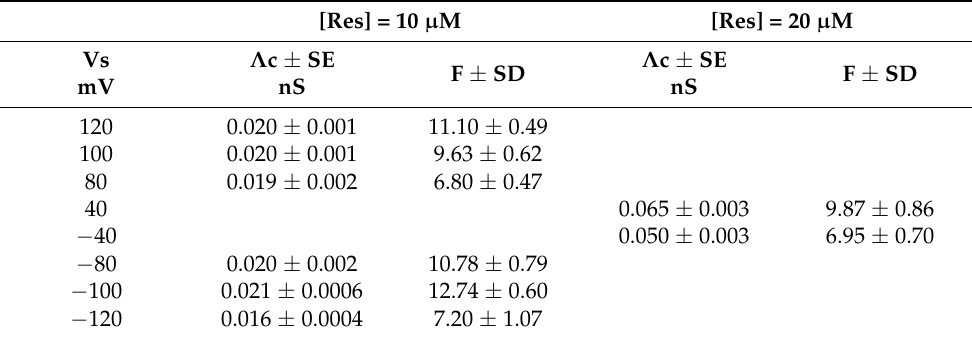
Table 3. Characteristic parameters of resveratrol channel-like event in POPC:Ch PLM. The mean conductance ( Λ c ± SE) and frequency (F ± SD) of resveratrol channel-like events at different applied voltages. The minimum and maximum number of channel-like events considered (N) out of a total number of channel-like events considered (Nt) was: 186 < N < 516, at the resveratrol concentration of 10 µ M. The minimum and maximum number of channel-like events considered (N) out of a total number of channel-like events considered (Nt) was: 265 < N < 337, Nt = 602, at the resveratrol concentration of 20 µ M. [Res] = 10 µ M [Res] = 20 µ M Λ c ± SE Λ c ± SE Vs F ± SD nS mV nS